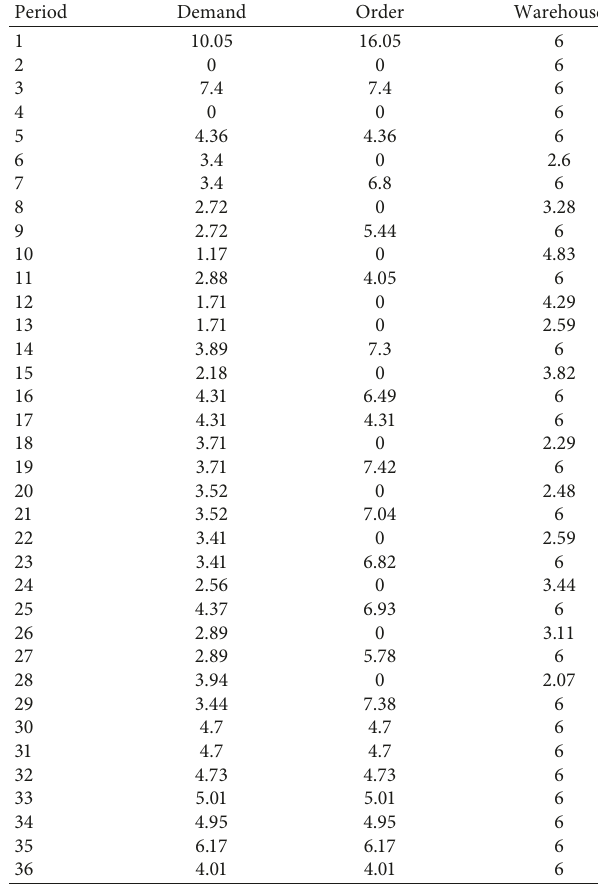
Table 6: Demand, order, and manufacturer warehouse by the neural network method.